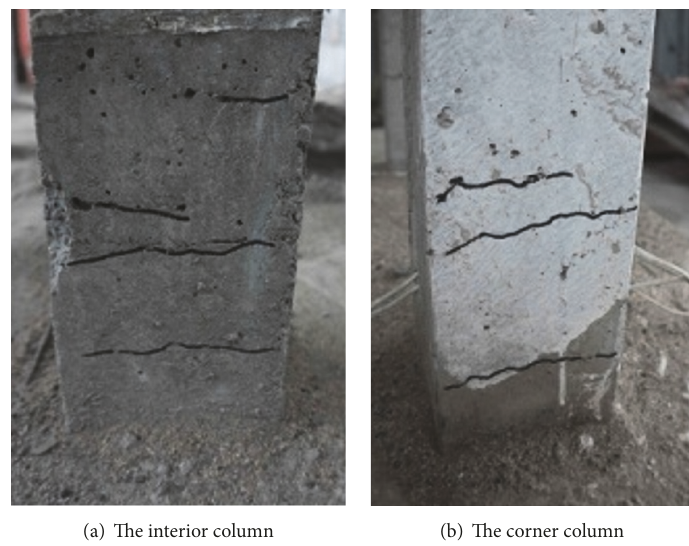
Figure 13: Cracks on columns at the first floor.